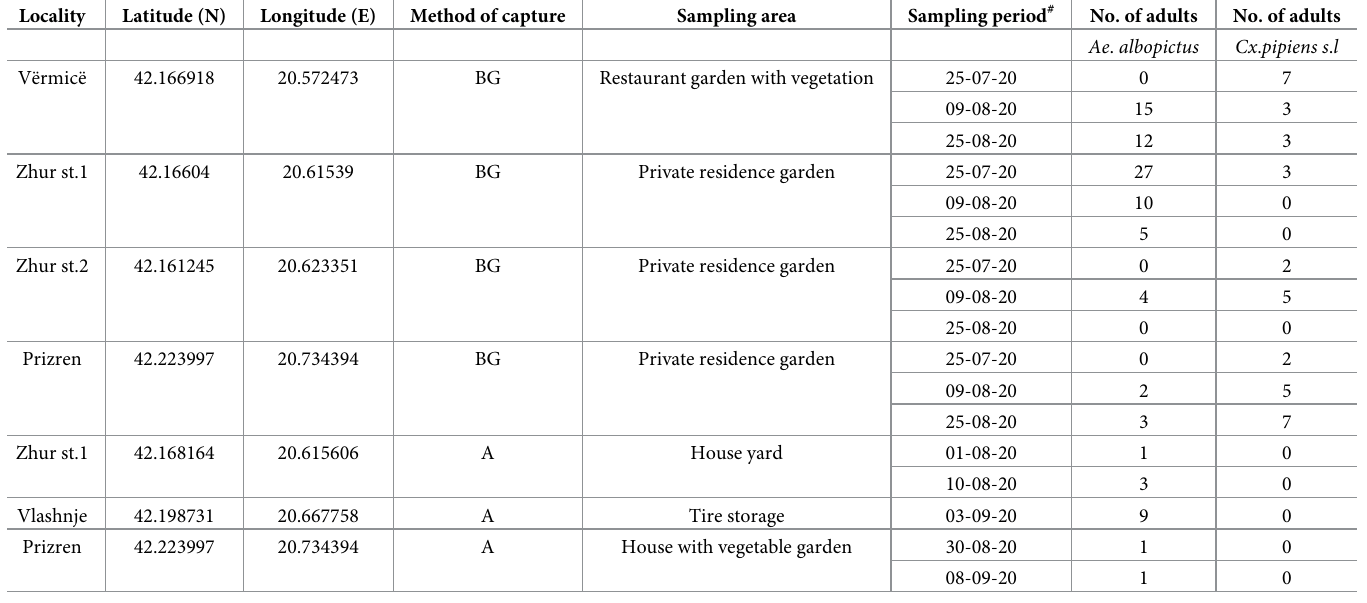
Table 1. Results of Aedes albopictus adult trapping with BG-Sentinel traps (BG) or handheld electric aspirators (A) in the Prizreni municipality (July -September